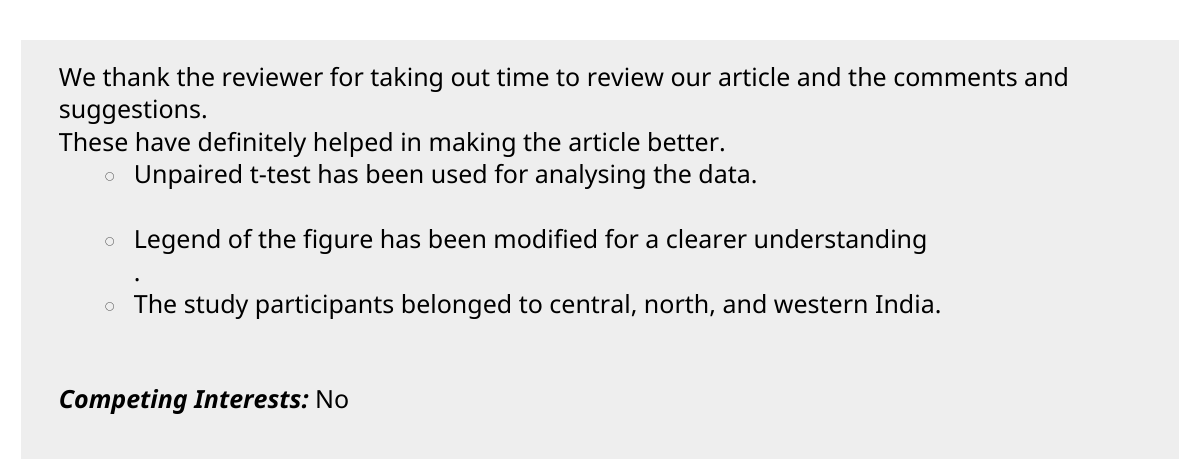
Table 2: Please, add percentages and chi-square test p-value to compare the categories.